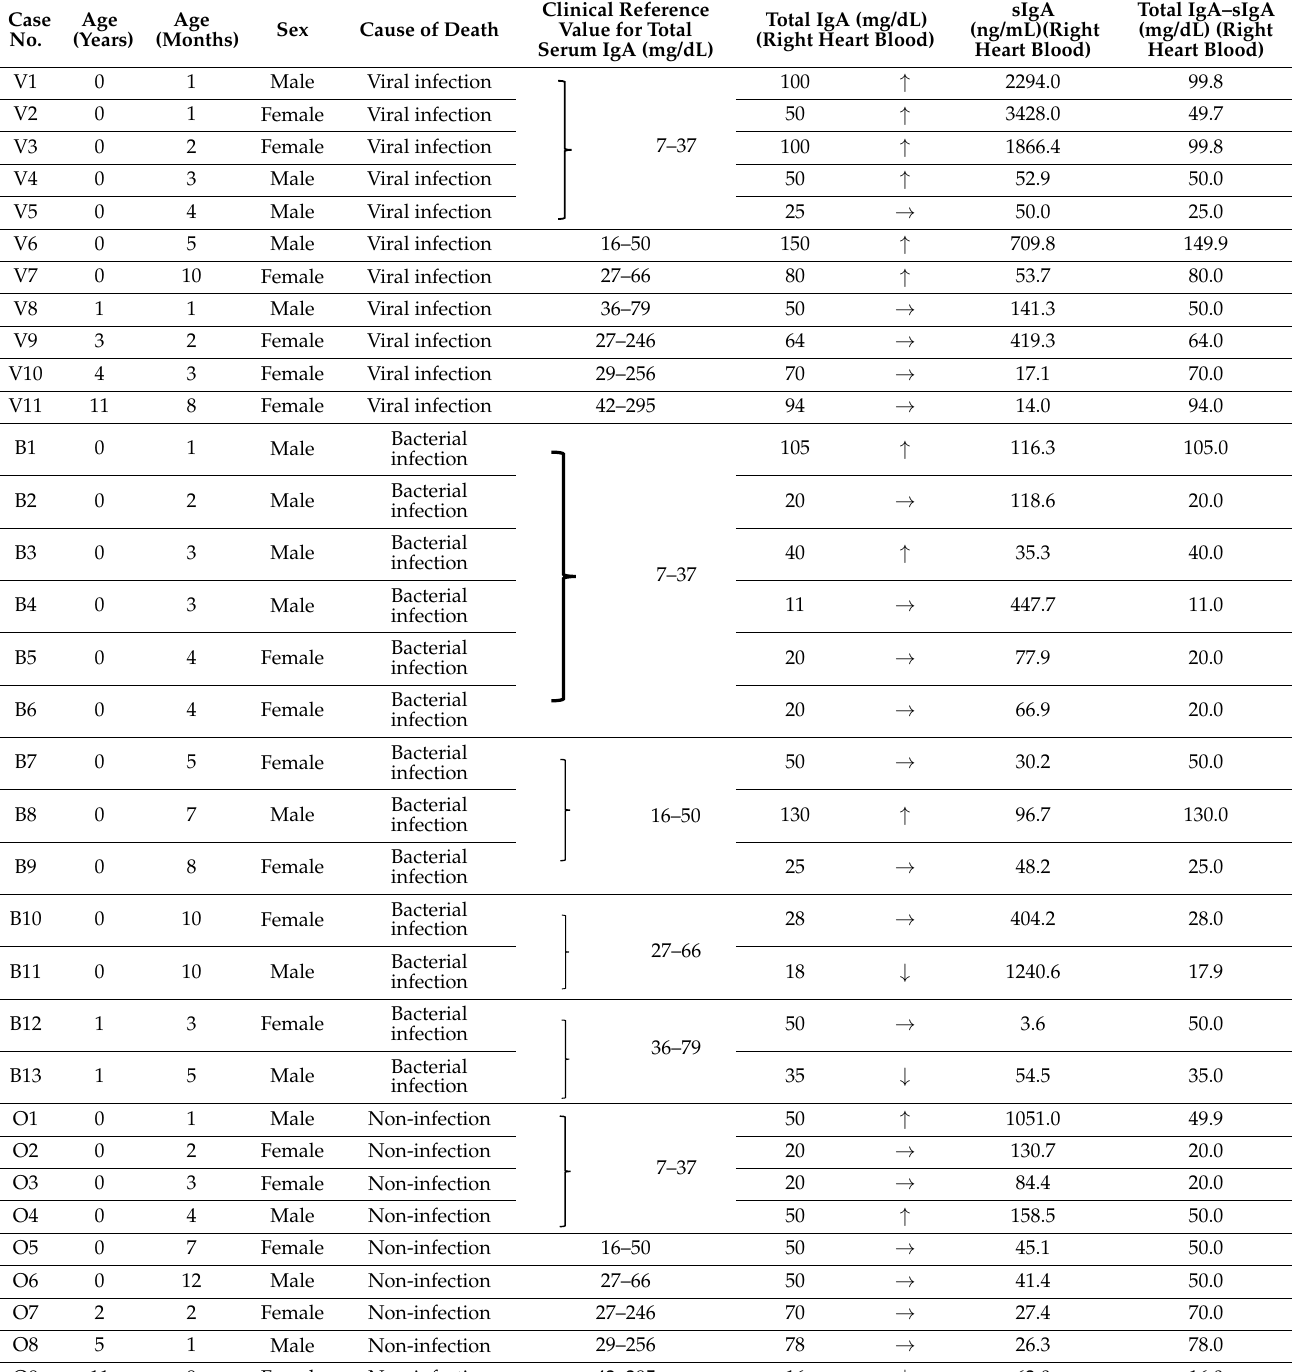
Table 1. Total serum IgA levels, serum sIgA levels, and total serum IgA–serum sIgA levels by infection